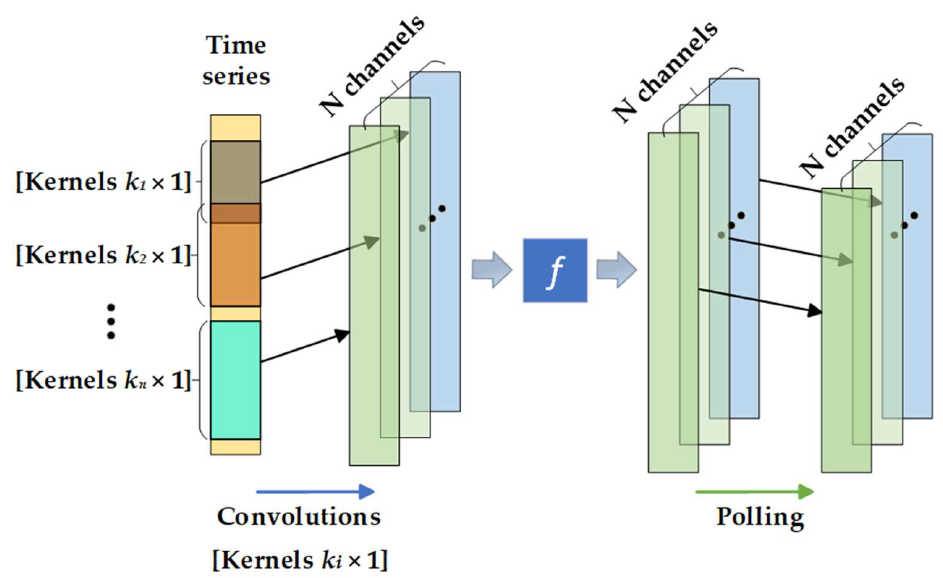
Figure 2. Structure of one-dimensional convolutional neural network.